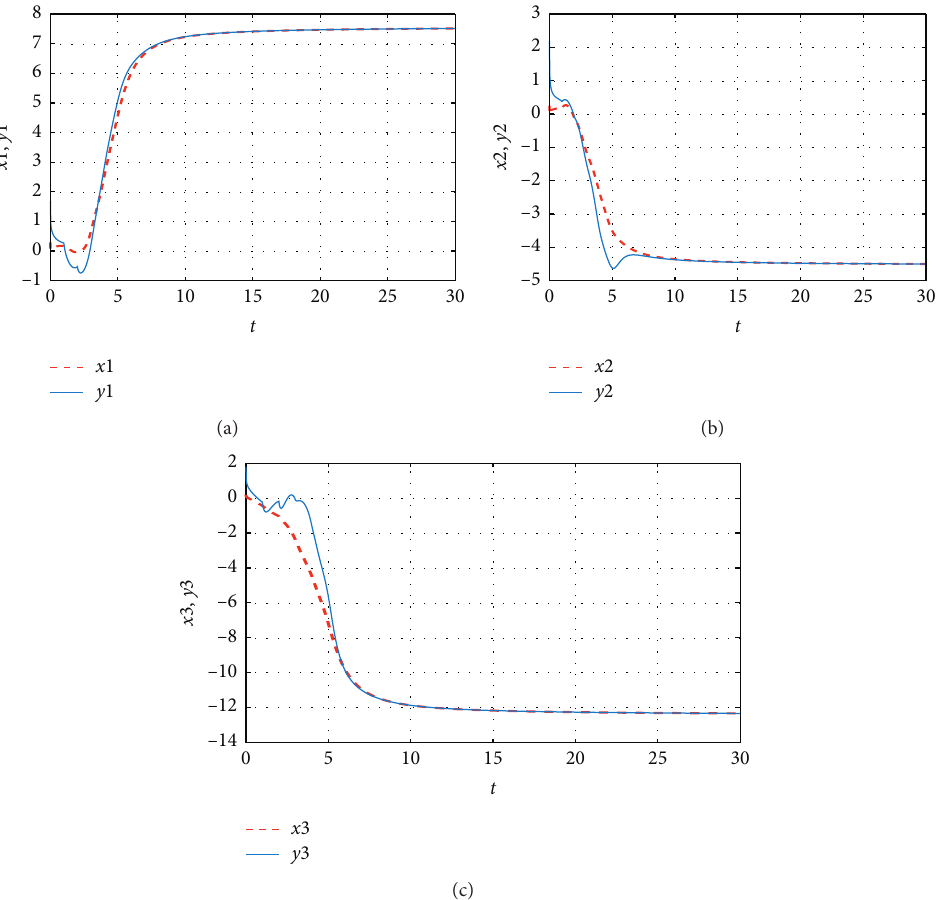
Figure 2: The change processes of x ( t ) and y ( t ) under the initial values (28) and (29).